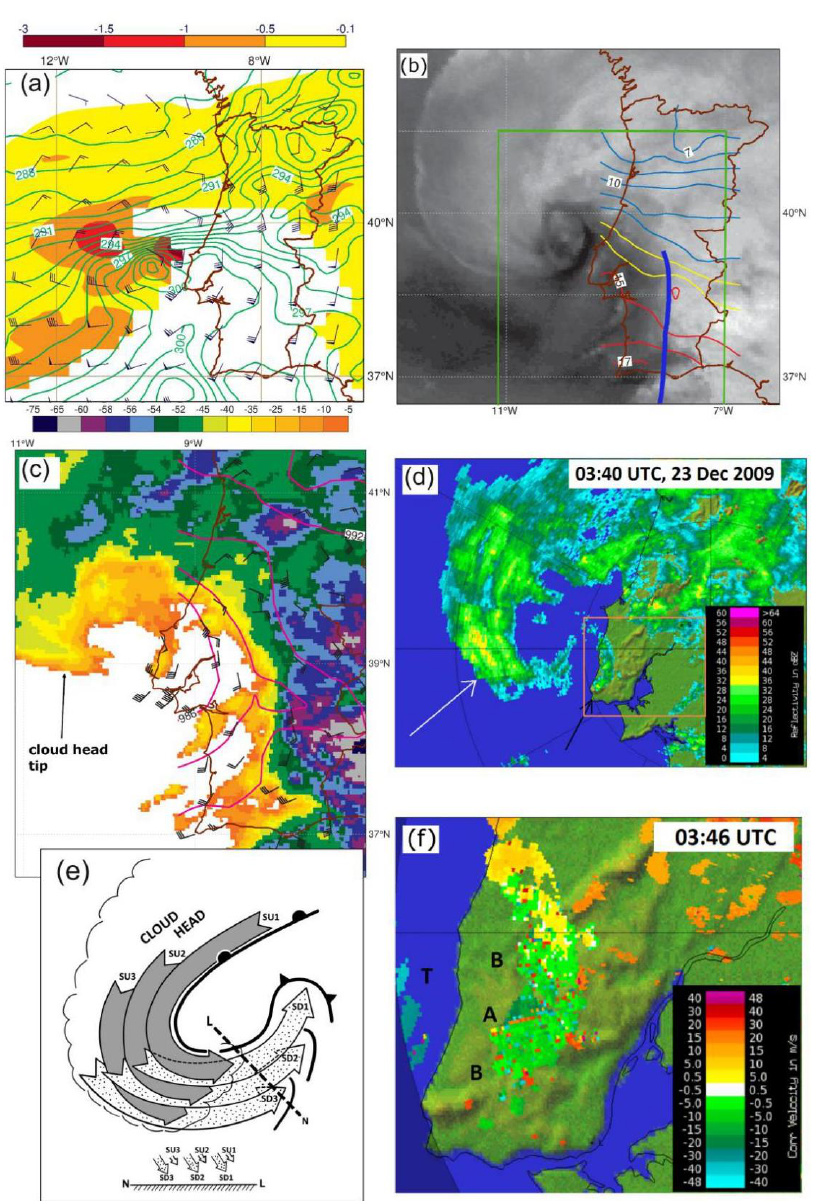
Figure 10. ( a ) MPV (PVU, shaded) in the layer 800–950 hPa, where SI and CI are absent, based on ECMWF forecasts for 03:00 UTC, on 23 / 12 / 2009. Winds (barbs) and potential temperature at 850 hPa (in Kelvin, green lines). ( b ) MSG WV6.2 image superimposed with observations of surface θ w (1 ◦ C intervals, from 8 to 12 ◦ C in blue, 13 and 14 ◦ C in red lines and ≥ 15 ◦ C in red lines) at 03:40 UTC. The UCF is marked with a blue line; ( c ) Zoom-in of the area indicated by the green rectangle in ( b ) of IR10.8 brightness temperature (shaded from − 5 to − 75 ◦ C) superimposed with observations of MSLP (2 hPa intervals, magenta lines) and wind gust at 10 m (barbs). The cloud head tip is also marked. ( d ) Radar MAXZ (dBZ) at 03:40 UTC, showing the cloud head (white arrow) and the arc-shaped cloud (black arrow). ( e ) Conceptual model of slantwise convective circulations in the cloud head of an intense extra-tropical cyclone. Adapted from Browning [3]. ( f ) Zoom-in of the area indicated by the rectangle in ( d ) of PPI of SRV (0.1 ◦ elevation) at 03:46 UTC, showing the arc-shaped pattern. “T”, “A” and “B” mark areas where SRV is 34.2 m s − 1 , 21.3 m s − 1 and 1–7 m s − 1 ,